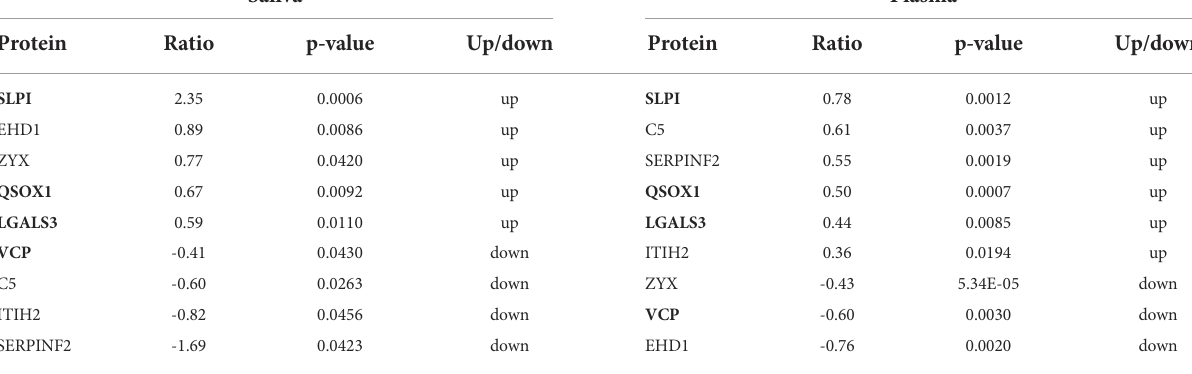
TABLE 6 Overlapped proteins identi fi ed in saliva and plasma of IgG4-RD patients.